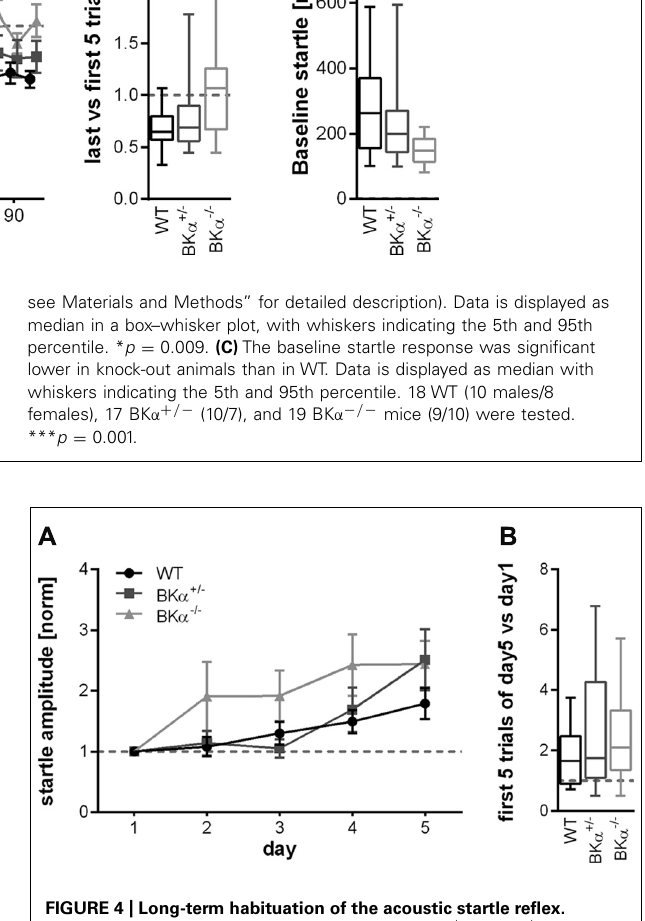
FIGURE 4 | Long-term habituation of the acoustic startle reflex. (A) Normalized startle response amplitudes of BK α − / − , BK α + / − , andWT mice over five consecutive days.The amplitude of the first block (first five responses) per day were averaged for each day and normalized to the first day of each animal. None of the genotypes showed long-term habituation, but rather sensitization.There was no statistically significant difference between genotypes. Averaged data for genotypes and standard errors are displayed. In (B) the habituation scores (first five versus last five responses) of the respective genotypes are displayed as median and whiskers indicating the 5th and 95th percentile (see Materials and Methods for detailed description). 18WT (10 males/8 females), 17 BK α + / − (10/7), and 19 BK α − / − mice (9/10) were